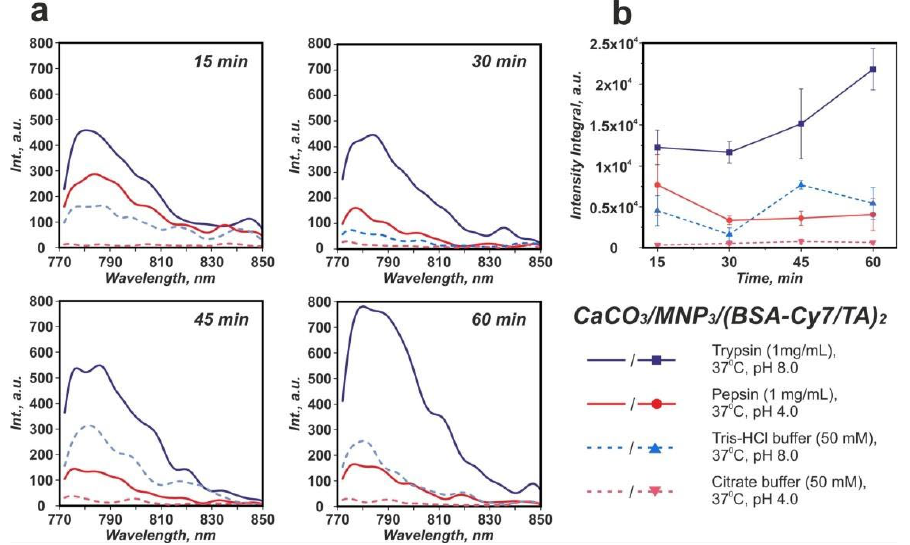
Figure 4. Averaged emission spectra of BSA-Cy7 in supernatants ( λ ex = 745 nm) after different time of incubation in solutions, with the emission maximum of BSA-Cy7 at 788 nm ( a ); emission intensity integral in the 772–804 nm range. Error bars represent the standard deviation of values estimated on the basis of three repetitive degradation processes ( b ).